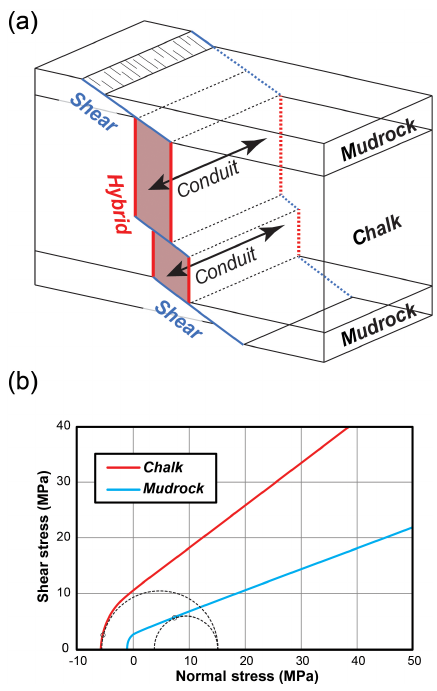
Figure 6. (a) Schematic block diagram illustrating the change in failure angle and mode from mudrock to chalk and the associated dilation of the steeper hybrid segment and formation of a fault con- duit parallel to the fault-bedding intersection direction. (b) Inter- preted failure envelopes and stress circles for chalk and mudrock at the time of failure with a uniform effective overburden stress of 15MPa (corrected for pore fluid pressure), with hybrid failure pre- dicted for the more competent chalk beds and shear failure predicted for the less competent